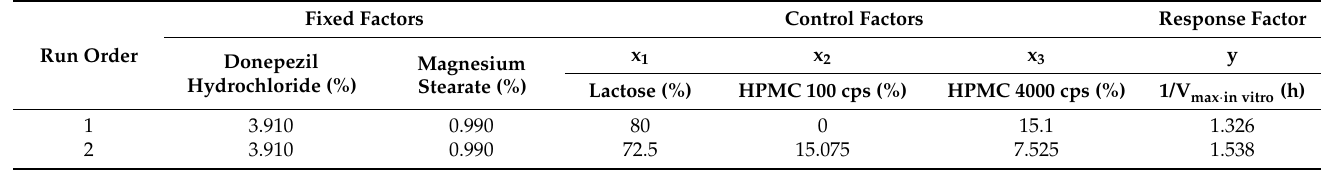
Table 1. The experimental design for donepezil SR formulations and the observed dissolution parameters.